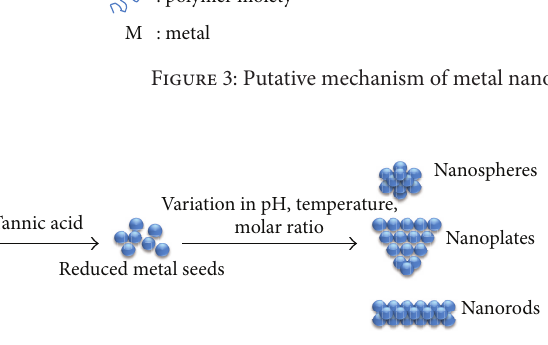
Figure 4: Schematic representation of various morphologies of metal nanoparticles obtained upon tannic acid mediated reduction of metal ions in response to variation in pH, temperature and molar